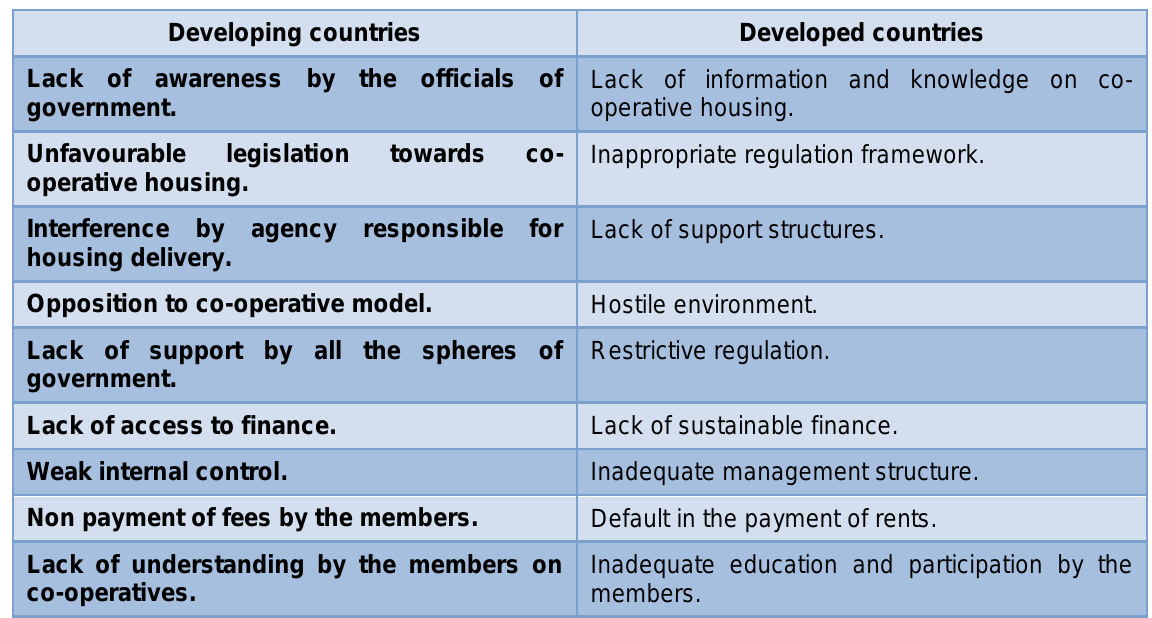
Table 2 Problems Experienced by Housing Co-operatives in Developing and Developed Countries (Source: Authors own